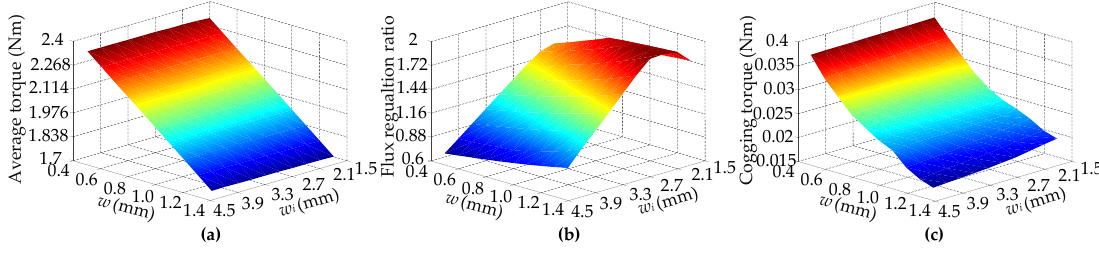
Figure 9. RS optimization results. ( a ) Average torque versus w and w i ; ( b ) Flux regulation ratio versus w and w i ; ( c ) Cogging torque versus w and w i .